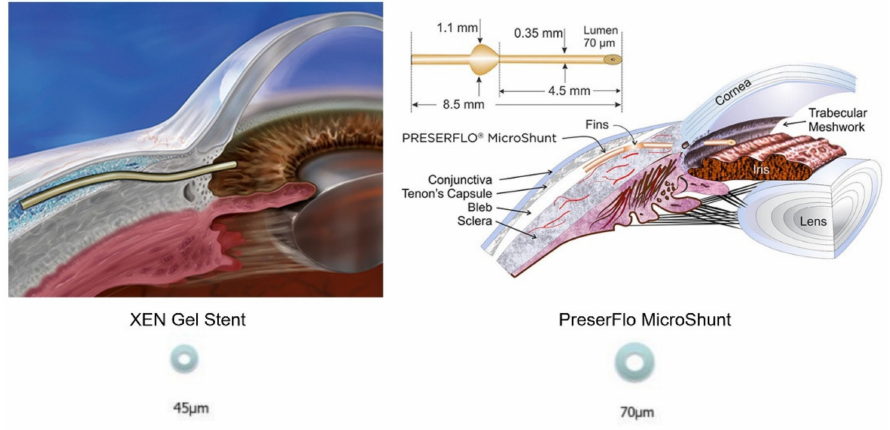
Figure 1. Graphical representation of XEN Gel Stent ( left ) and PreserFlo MicroShunt ( right